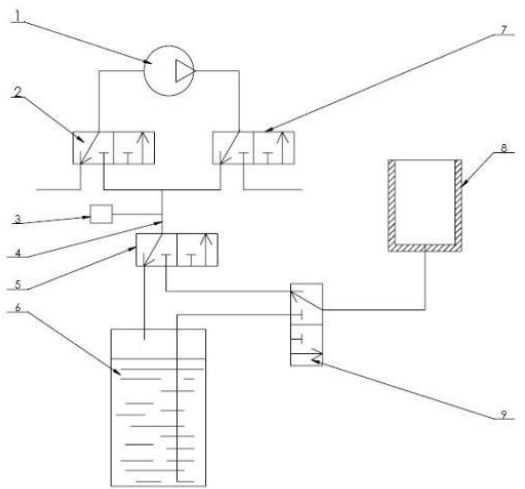
Figure 6. Air pressure control system. 1. vacuum air pump; 2. No. 1 solenoid valve; 3. barometric pressure sensor; 4. Public pipeline; 5. No. 3 solenoid valve; 6. waste tank; 7. No. 2 solenoid valve; 8. membrane tube; 9. No. 4 solenoid